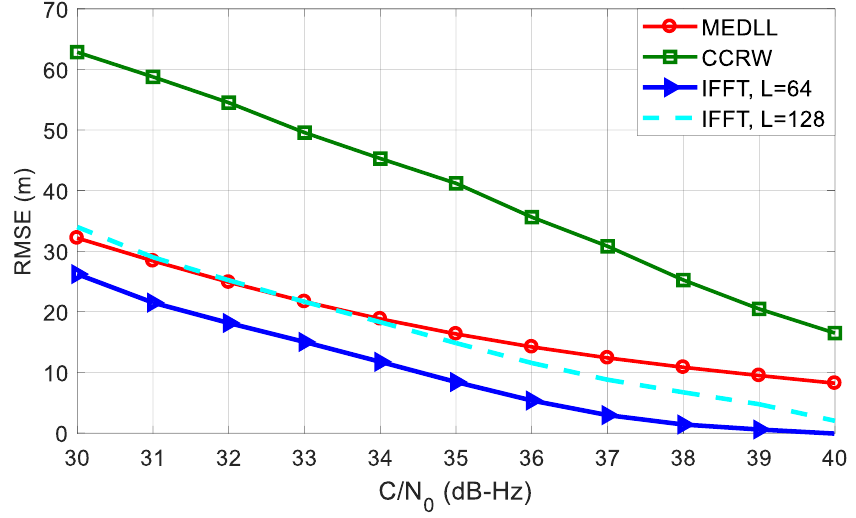
Figure 15. RMSE curves of different methods for BOC(14,2) signal with single reflected path.